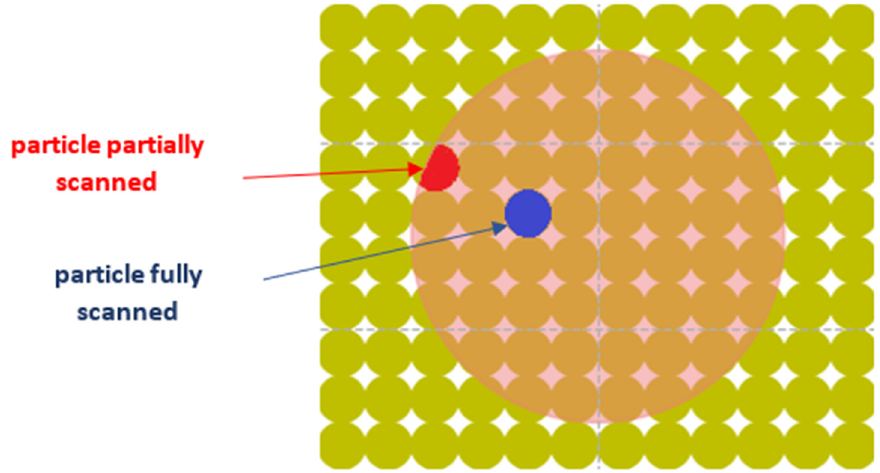
Figure 8. View of the particles completely and partially swept by the laser beam.